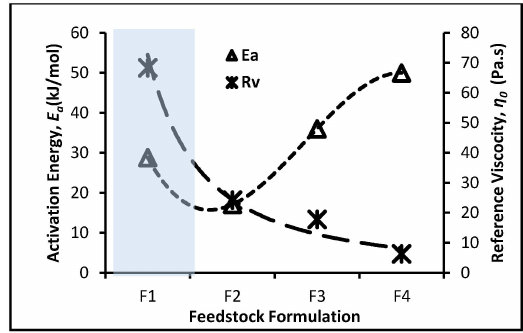
Figure 9. Determination of critical feedstock formulation between Activation energy, E a and Reference viscosity, η 0